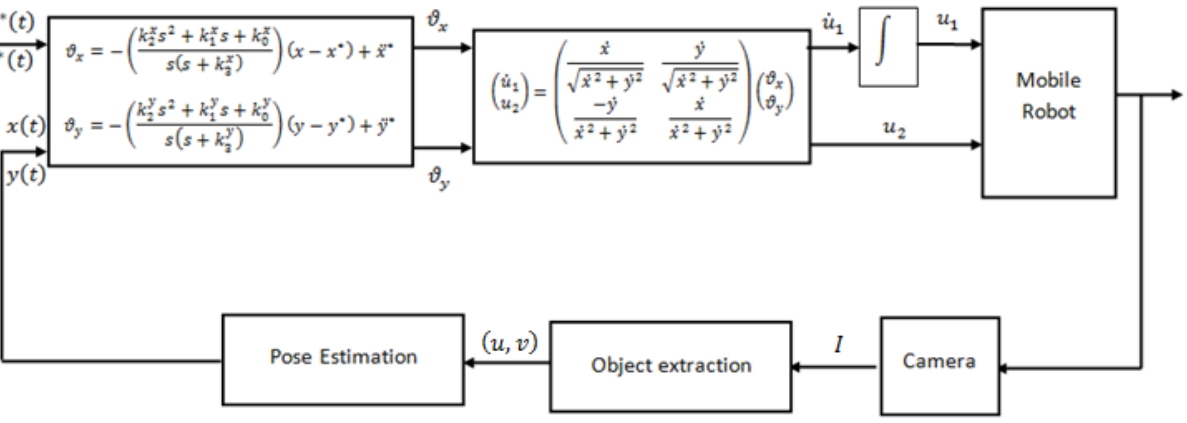
Figure 10. Visual servo control diagram: object does not leave the field of view of the camera.